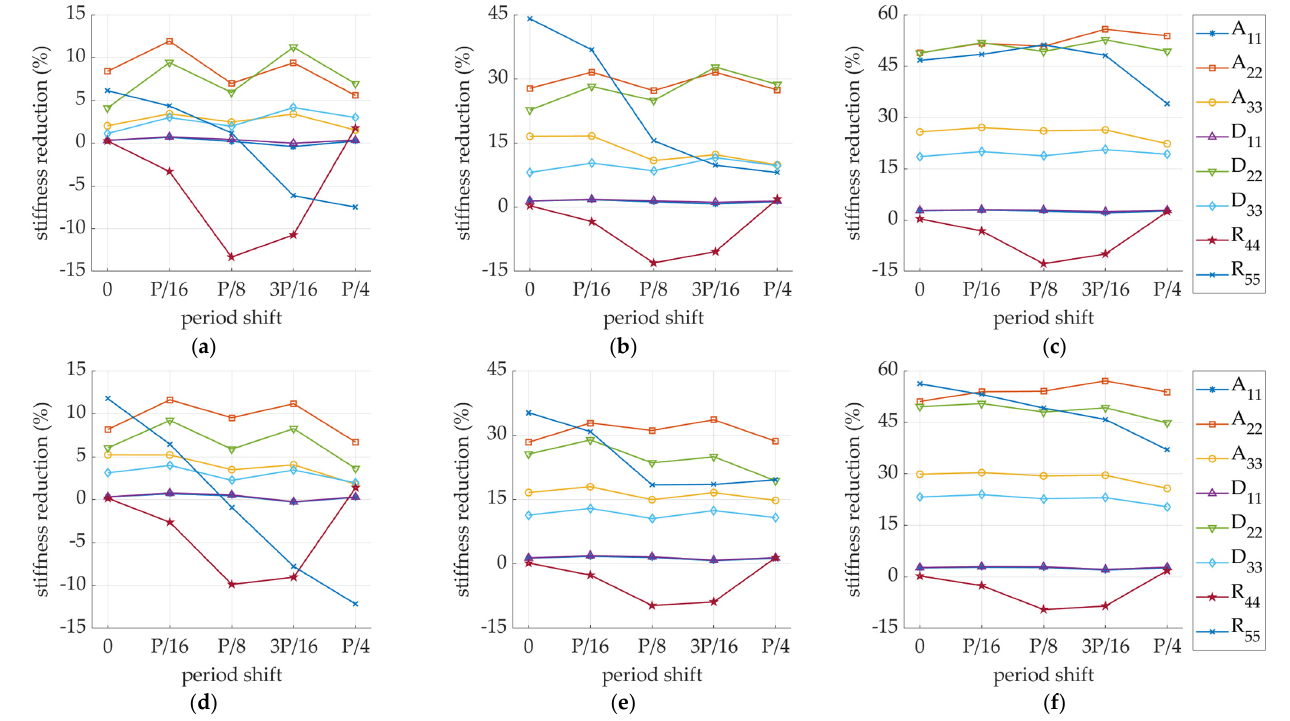
Figure 15. Stiffness degradation in sample C-0: ( a ) SW-26; ( b ) SW-44; ( c ) SW-62; ( d ) DW-26; ( e ) DW-44; ( f ) DW-62.